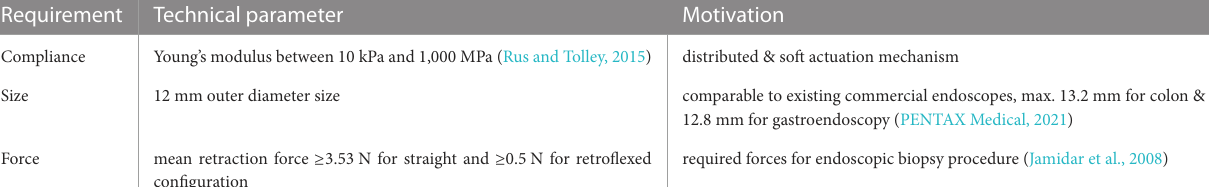
TABLE1 Designchoicesandrequirementsofthefiberreinforcedsoftpneumaticendoscopemodule.